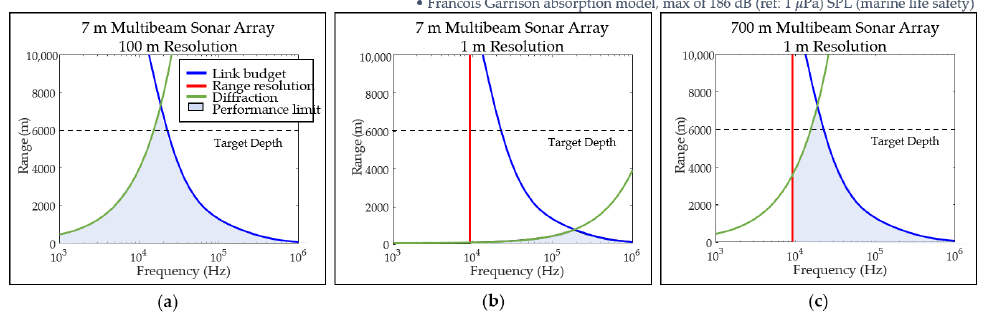
Figure 3. The performance-bound trade-off between imaging distance, resolution, frequency, and aperture. ( a ) A 7 m sonar array can achieve 100 m resolution at the target depth of 6 km. ( b ) A resolution of 1 m is possible, but the range is limited to 1 km. ( c ) A large 700 m aperture sonar can achieve 1 m resolution at the target depth and